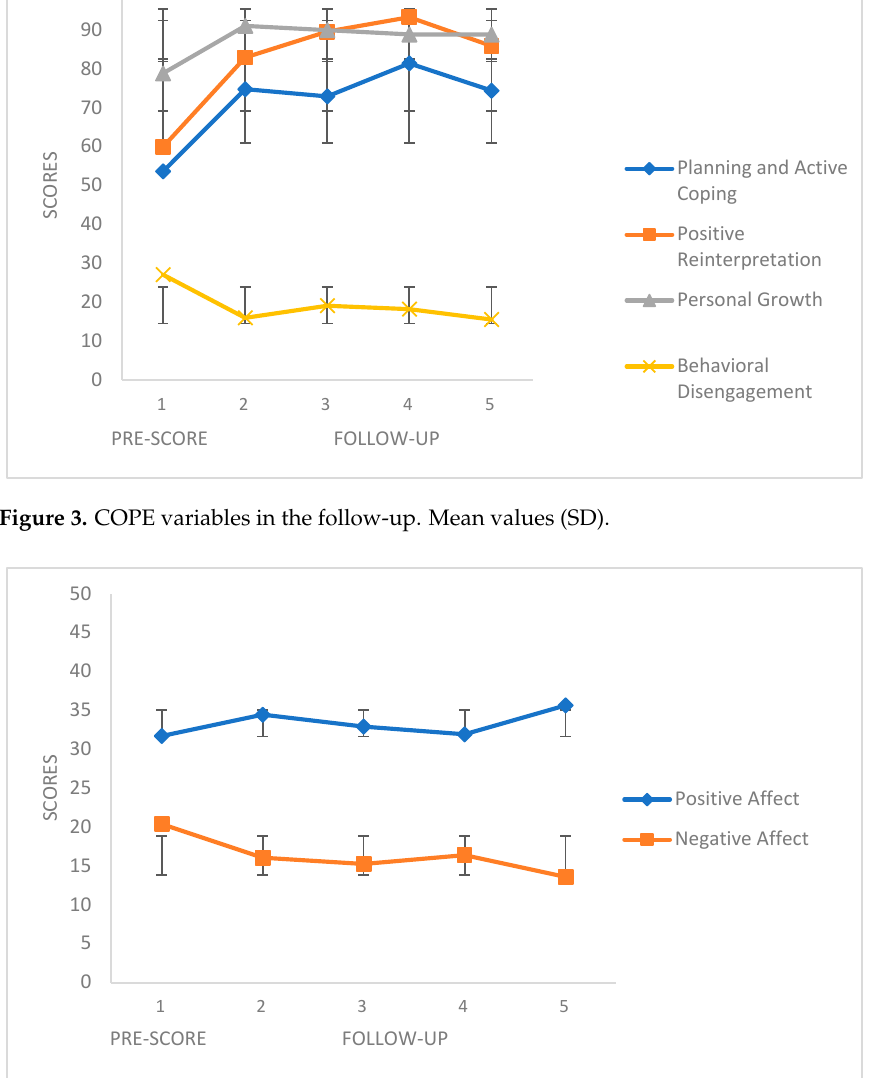
tion for COPE and PANAS variables.